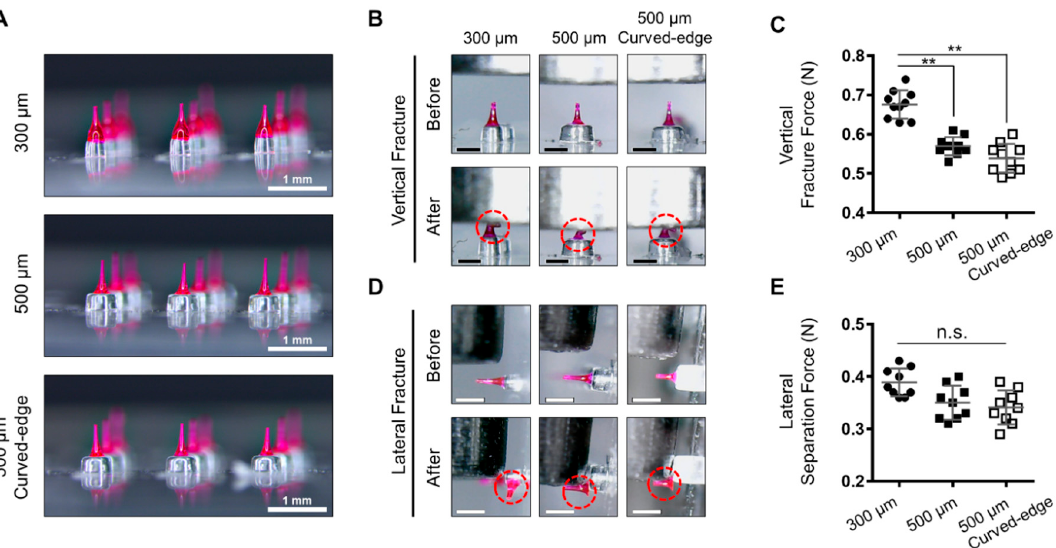
Figure 2. Fracture and separation force analysis. ( A ) DMNs were fabricated over 300 µ m, 500 µ m, and curved-edge 500 µ m micropillars. ( B ) The process of fracture force assessment. ( C ) Mean fracture force of DMNs against the analyzer probe. ( D ) Separation force analysis through lateral probe analysis. ( E ) The lateral separation force of DMNs showed that less force was required to detach DMNs from both 500 µ m micropillars. Dashed circles in ( B , D ) indicate DMNs post-analysis. Scale bars in ( A ) are 1 mm and in ( B , D ) are 500 µ m. Data in ( C , E ) are expressed as mean ± S.D. **: p < 0.01. n.s.: not